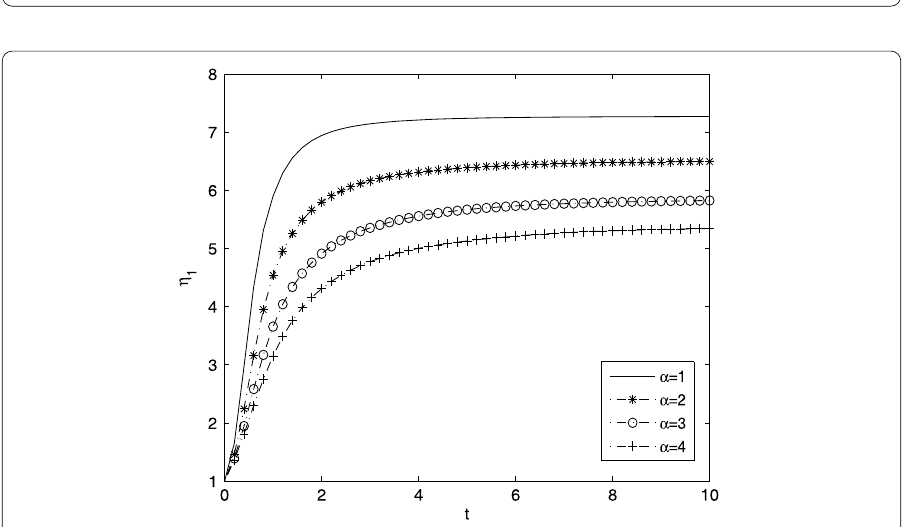
Figure 5 η 1 versus time for different values of α when applying the linear adaptive control law